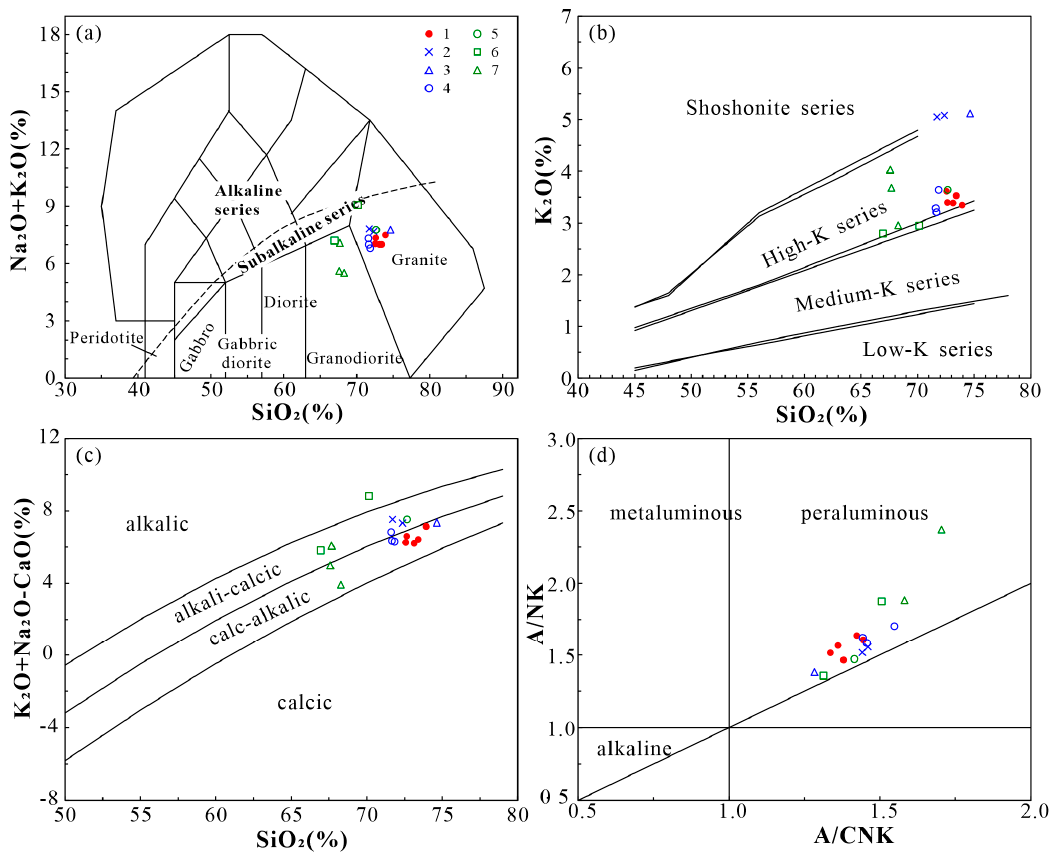
Figure 4. Major element diagrams of the Dongcao muscovite granite: ( a ). TAS diagram (the base map is derived from [22]); ( b ). K 2 O vs. SiO 2 diagram (the base map is derived from [23]); ( c ). (K 2 O + Na 2 O + CaO) vs. SiO 2 diagram (the base map is derived from [24]); ( d ). A/NK vs. A/CNK diagram (the base map is derived from [25]). (Legend descriptions: the red dots are data of the Dongcao muscovite granite samples in this paper; the blue crosses are data of the Dagang protolothionite muscovite granite; the blue triangles are data of the Dagang pegmatitic dike; and the blue circles are data of the Dagang lepidolite alkali–feldspar granite [8]; the green circles are data of the Baishuidong Li–rich muscovite granite; the green rectangles are data of the Baishuidong trilithionite granite; and the green triangles are data of the Baishuidong aplite [7].).